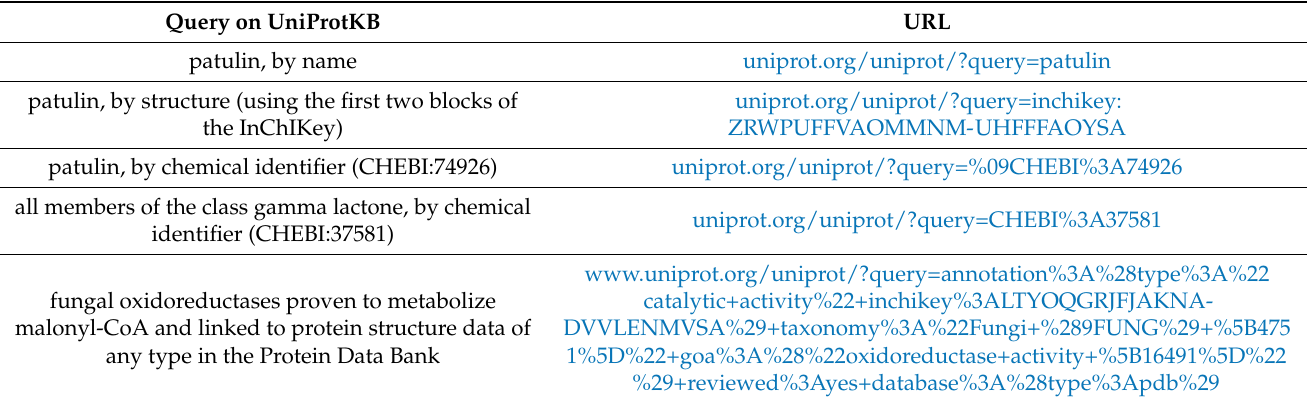
fungal oxidoreductases proven to metabolize malonyl-CoA and linked to protein structure data of any type in the Protein Data